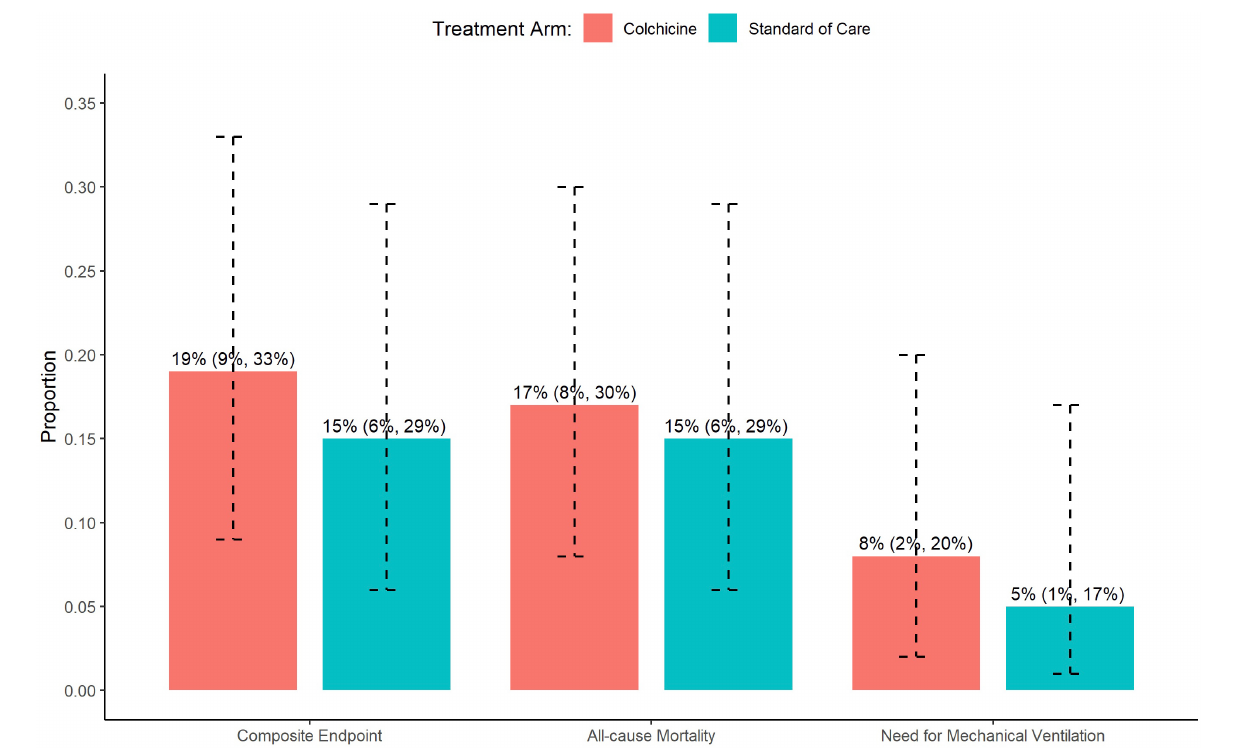
FIGURE 2 | Impact of colchicine on the primary composite endpoint, and individual components of the primary composite endpoint including all-cause mortality and need for mechanical ventilation.